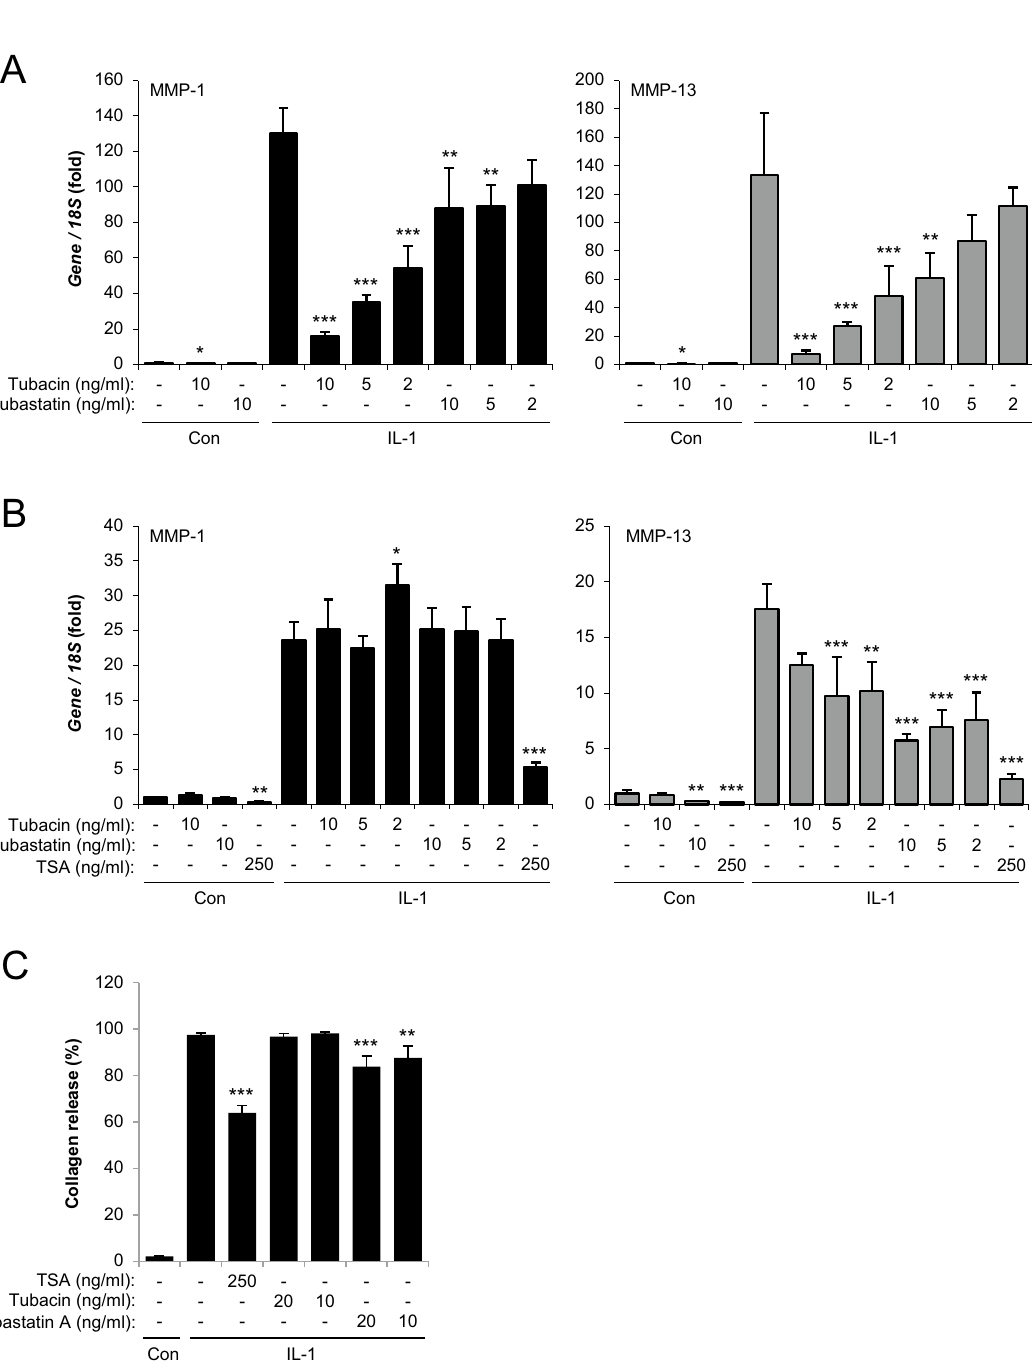
Figure 5. Effect of HDAC6 inhibition on MMP expression and cartilage degradation. A–B. ( A ) SW1353 and ( B ) HAC cells were stimulated with IL-1 for ( A ) 8 or ( B ) 24 h in the presence of HDACi at the indicated concentrations. RNA was extracted and expression of MMP1 and MMP13 measured by real-time RT-PCR normalised to 18S . Data are presented as fold induction relative to the basal expression and represent mean ± S.D. ( C ) Bovine nasal cartilage was cultured in serum-free medium in the presence of either medium alone, or medium containing IL-1 and HDACi TSA, tubacin, tubasatin A or DMSO control (0.01% v/v) at the indicated concentrations for 14 days. The levels of collagen fragments released into the medium were determined by measurement of hydroxyproline after day 14 of culture and expressed as a percentage of the total (mean ± S.D). All experiments were performed in quadruplicate. Significance was analysed compared to IL-1 alone, where, *p < 0.05, ** p < 0.01, *** p < 0.001. Data are representative of two independent